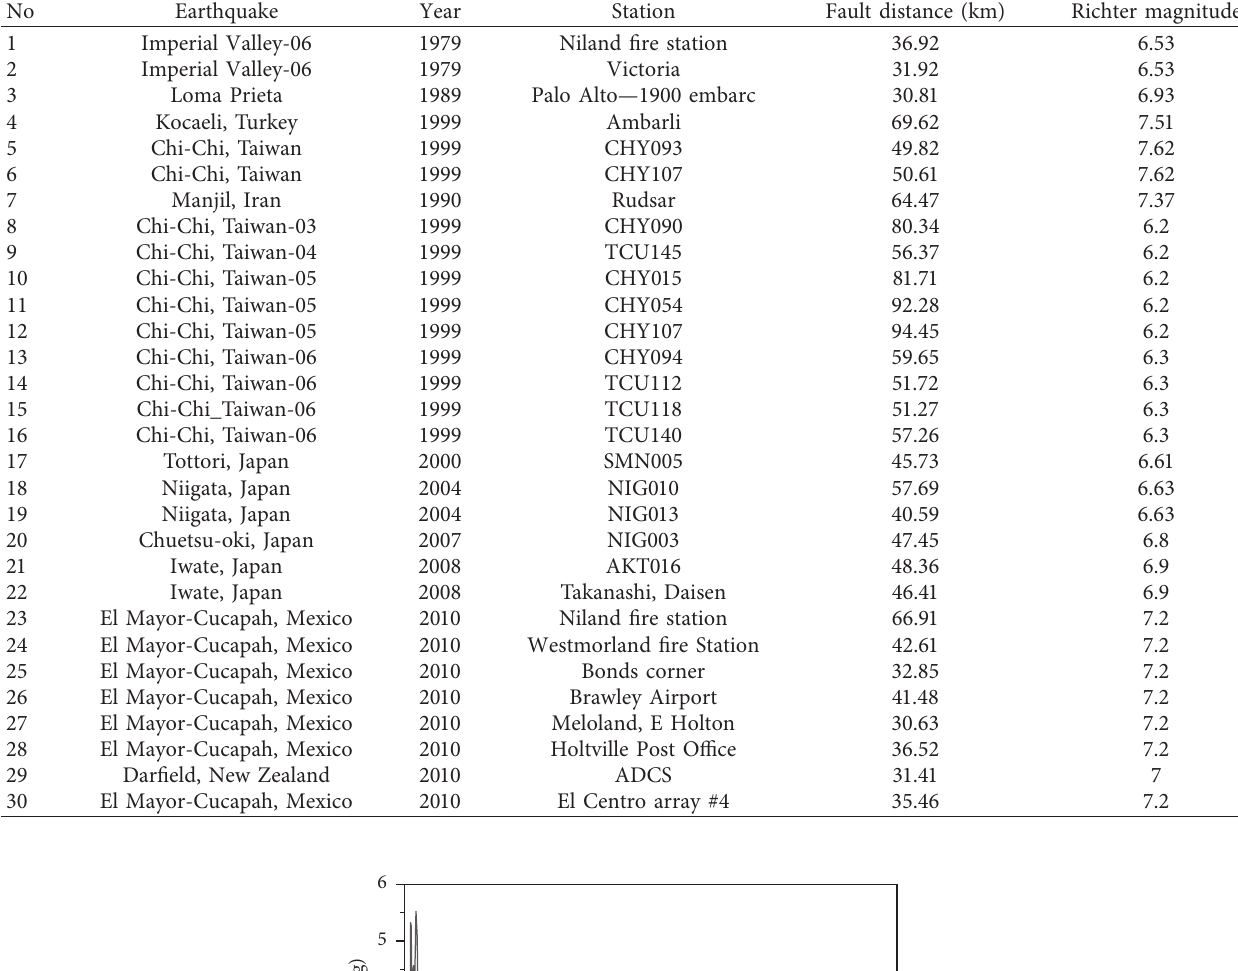
Table 3: Information of selected 30 far-fault earthquake